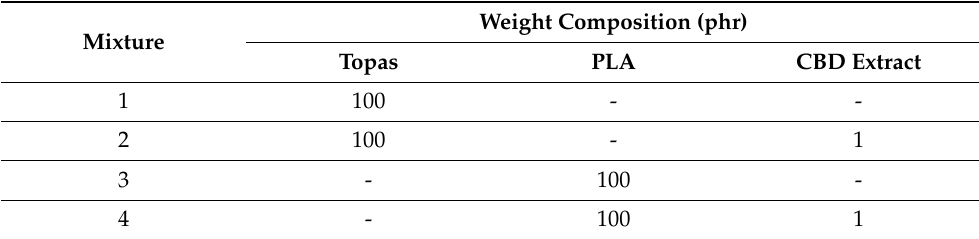
Table 5. The composition of ethylene-norbornene copolymer (Topas) and polylactide (PLA) based mixtures with the natural additive, cannabidiol